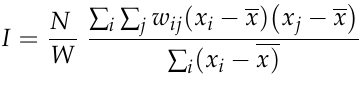
Limits of the Intervals ( x —Mean, δ —Standard